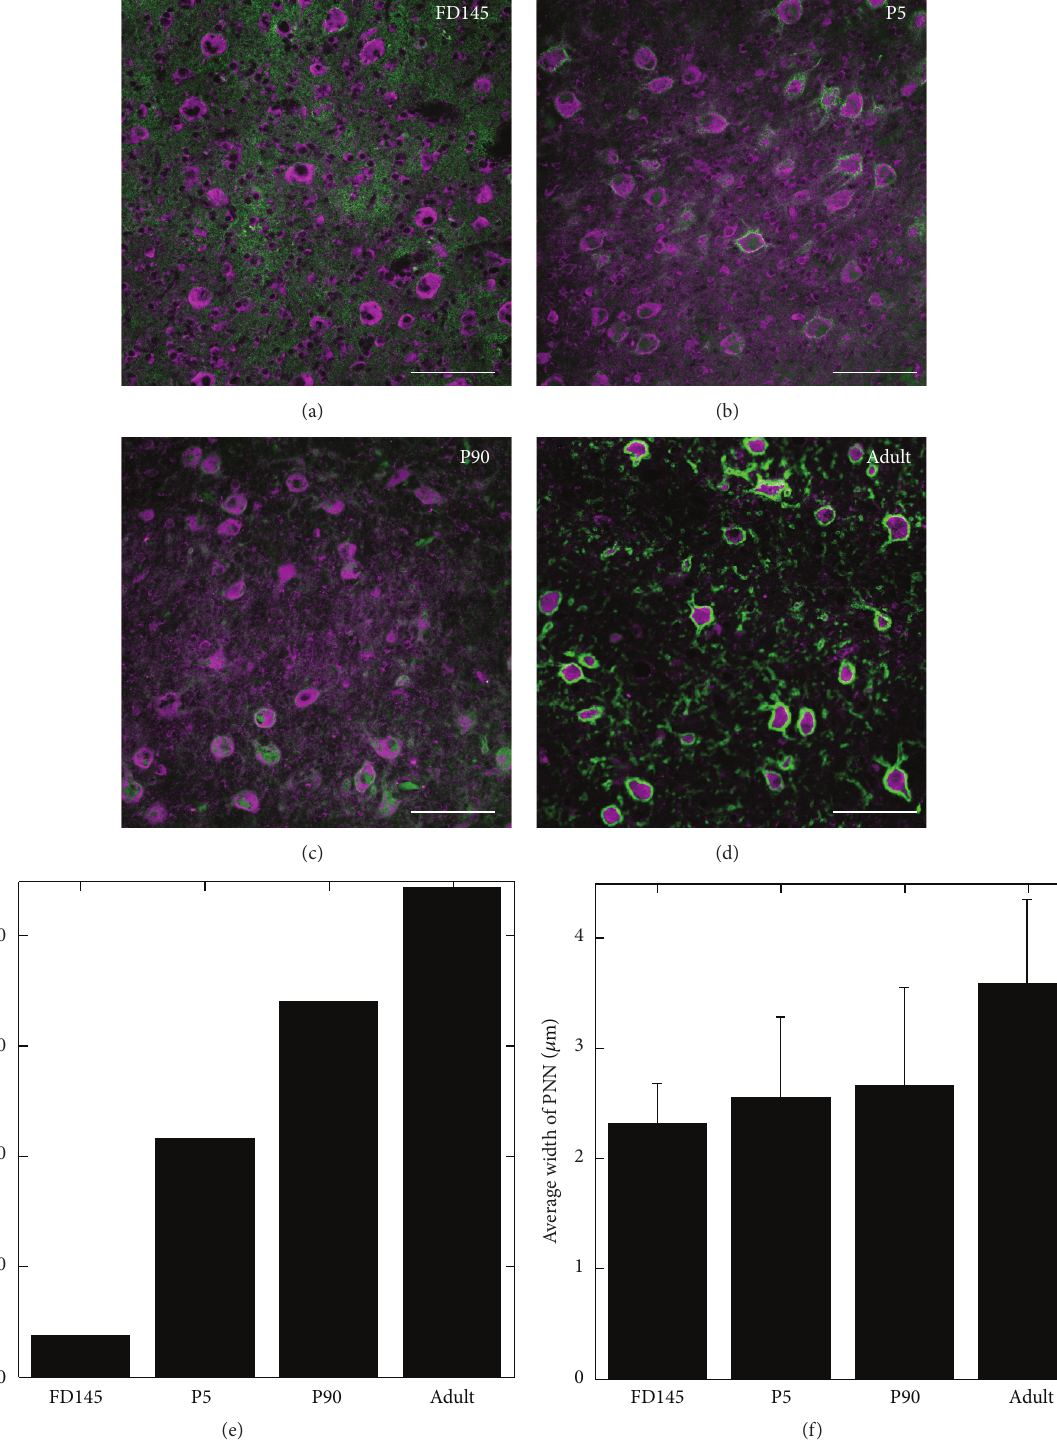
Figure 12: Perineuronal nets in the developing cerebellar nucleus. Perineuronal nets (stained with WFA, green) accrue around neurons in the cerebellar nuclei (stained with avidin, pink) between (a) fetal day 145, (b) postnatal day 5, (c) postnatal day 90, and (d) the adult animal. (e) shows the number of neurons surrounded by nets in (a)–(d). (f) shows the width of PNNs around cells in (a)–(d). Scale bars in (a)–(d) = 100 𝜇